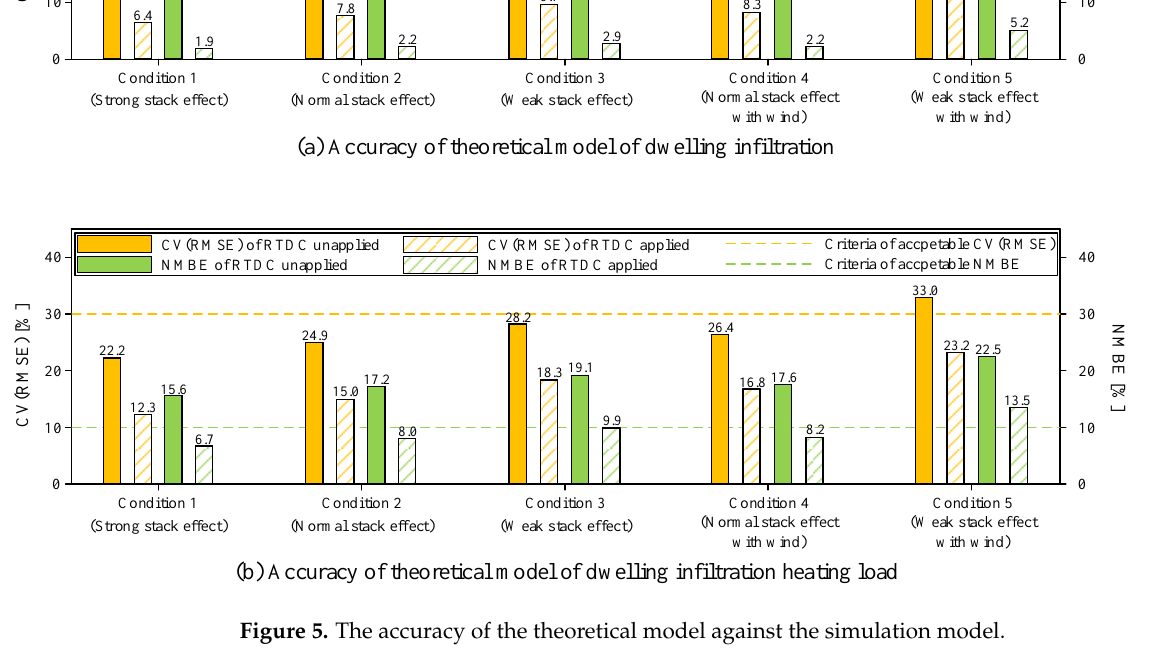
Figure 5. The accuracy of the theoretical model against the simulation model.